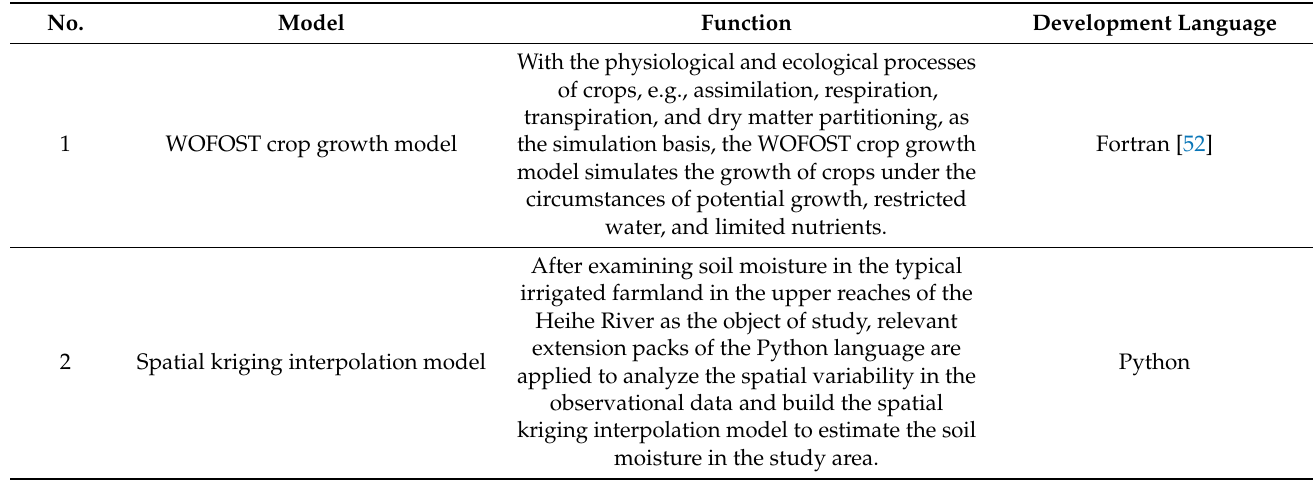
Table 4. Models integrated into the IODCS.